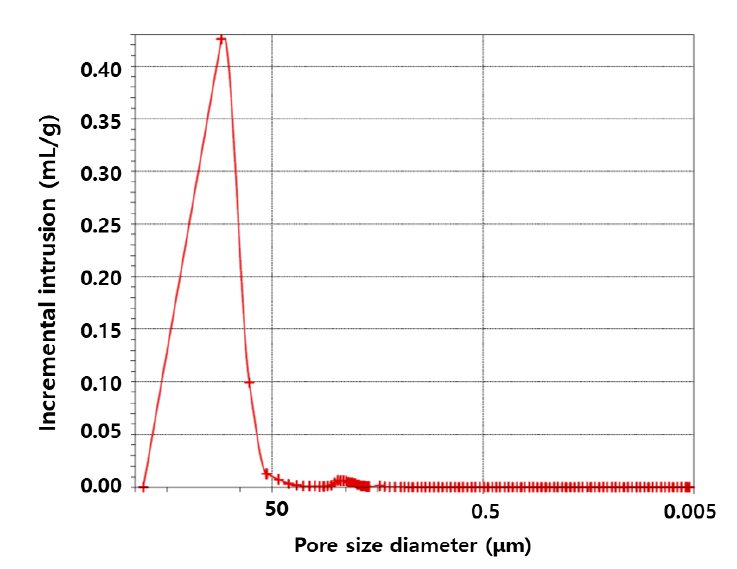
Figure 4. Incremental intrusion vs. pore size of metal foam.